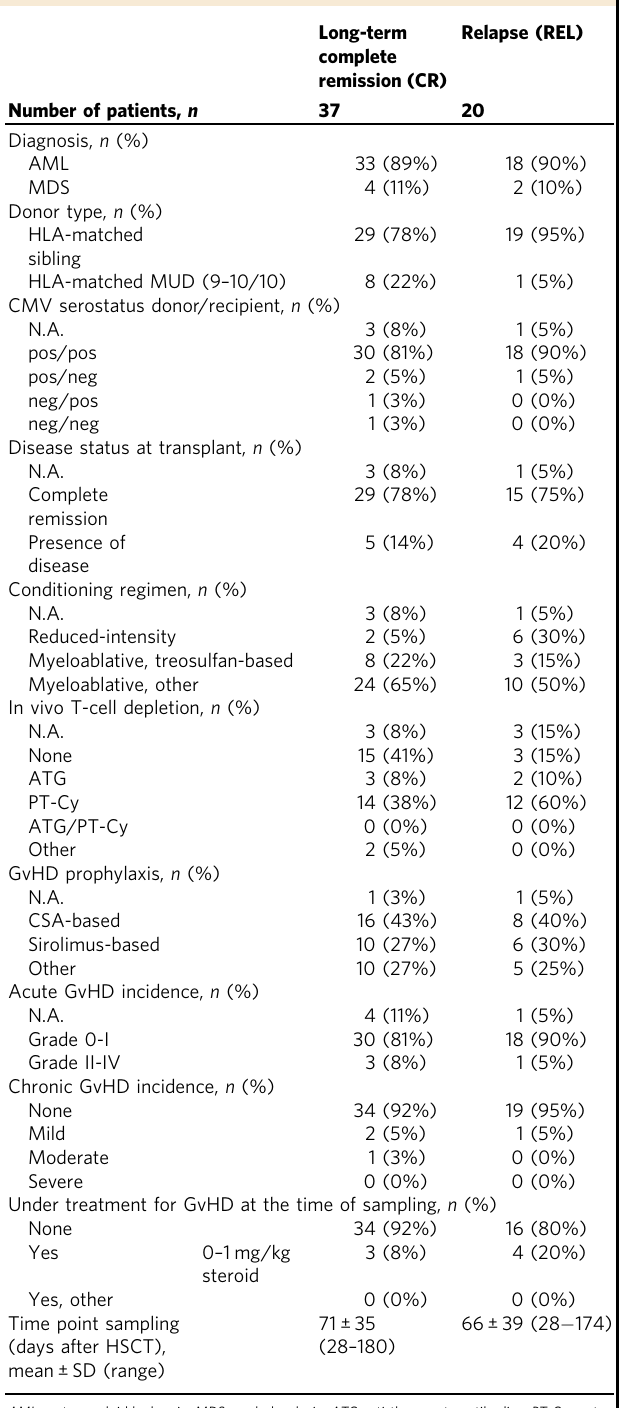
Table 2 Patients ’ characteristics at early time point